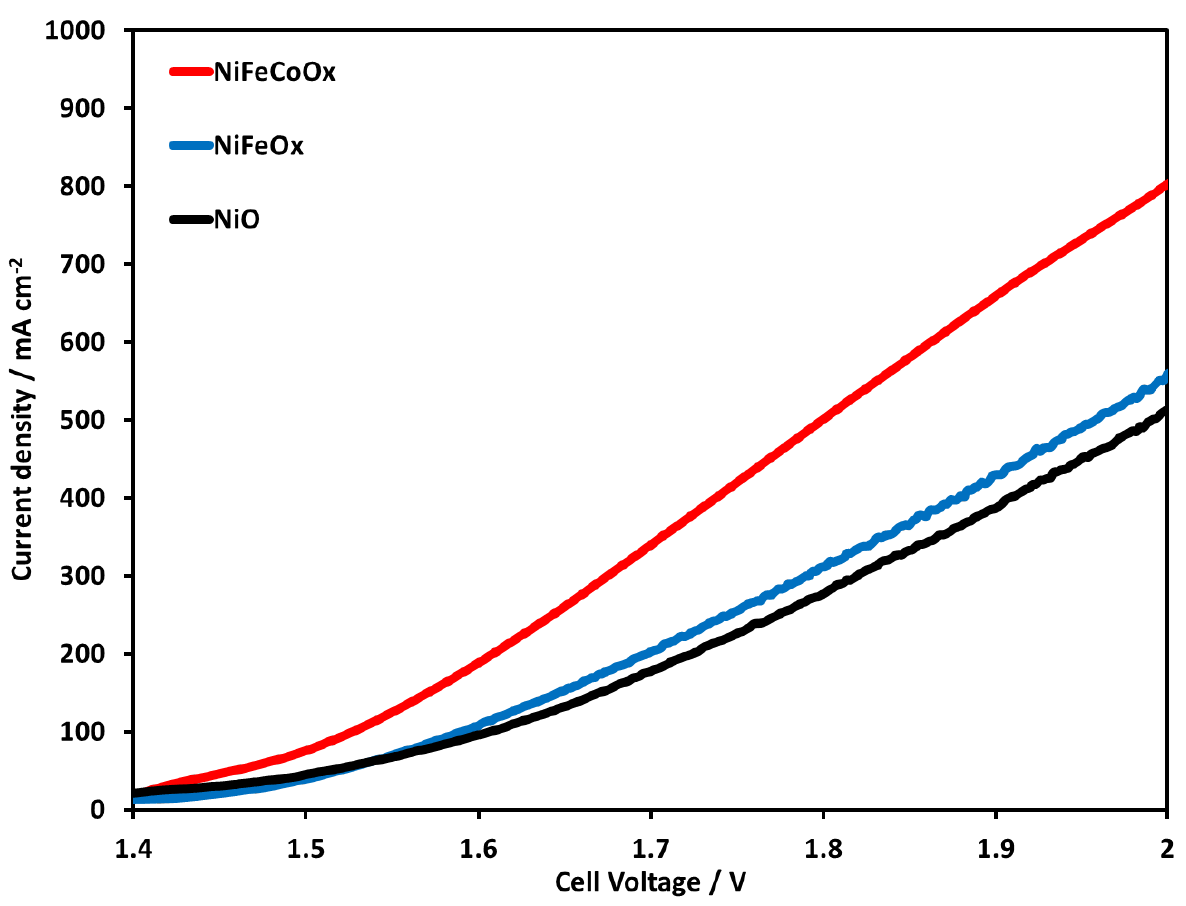
Figure 8. Linear Sweep Voltammetry at temperature of 70 °C. Pt/C was used at the cathode and NiO, NiFeO x , and NiFeCoO x were used at anode. FAA-3-50 membrane with a thickness of 50 µm was used in electrolysis operation.